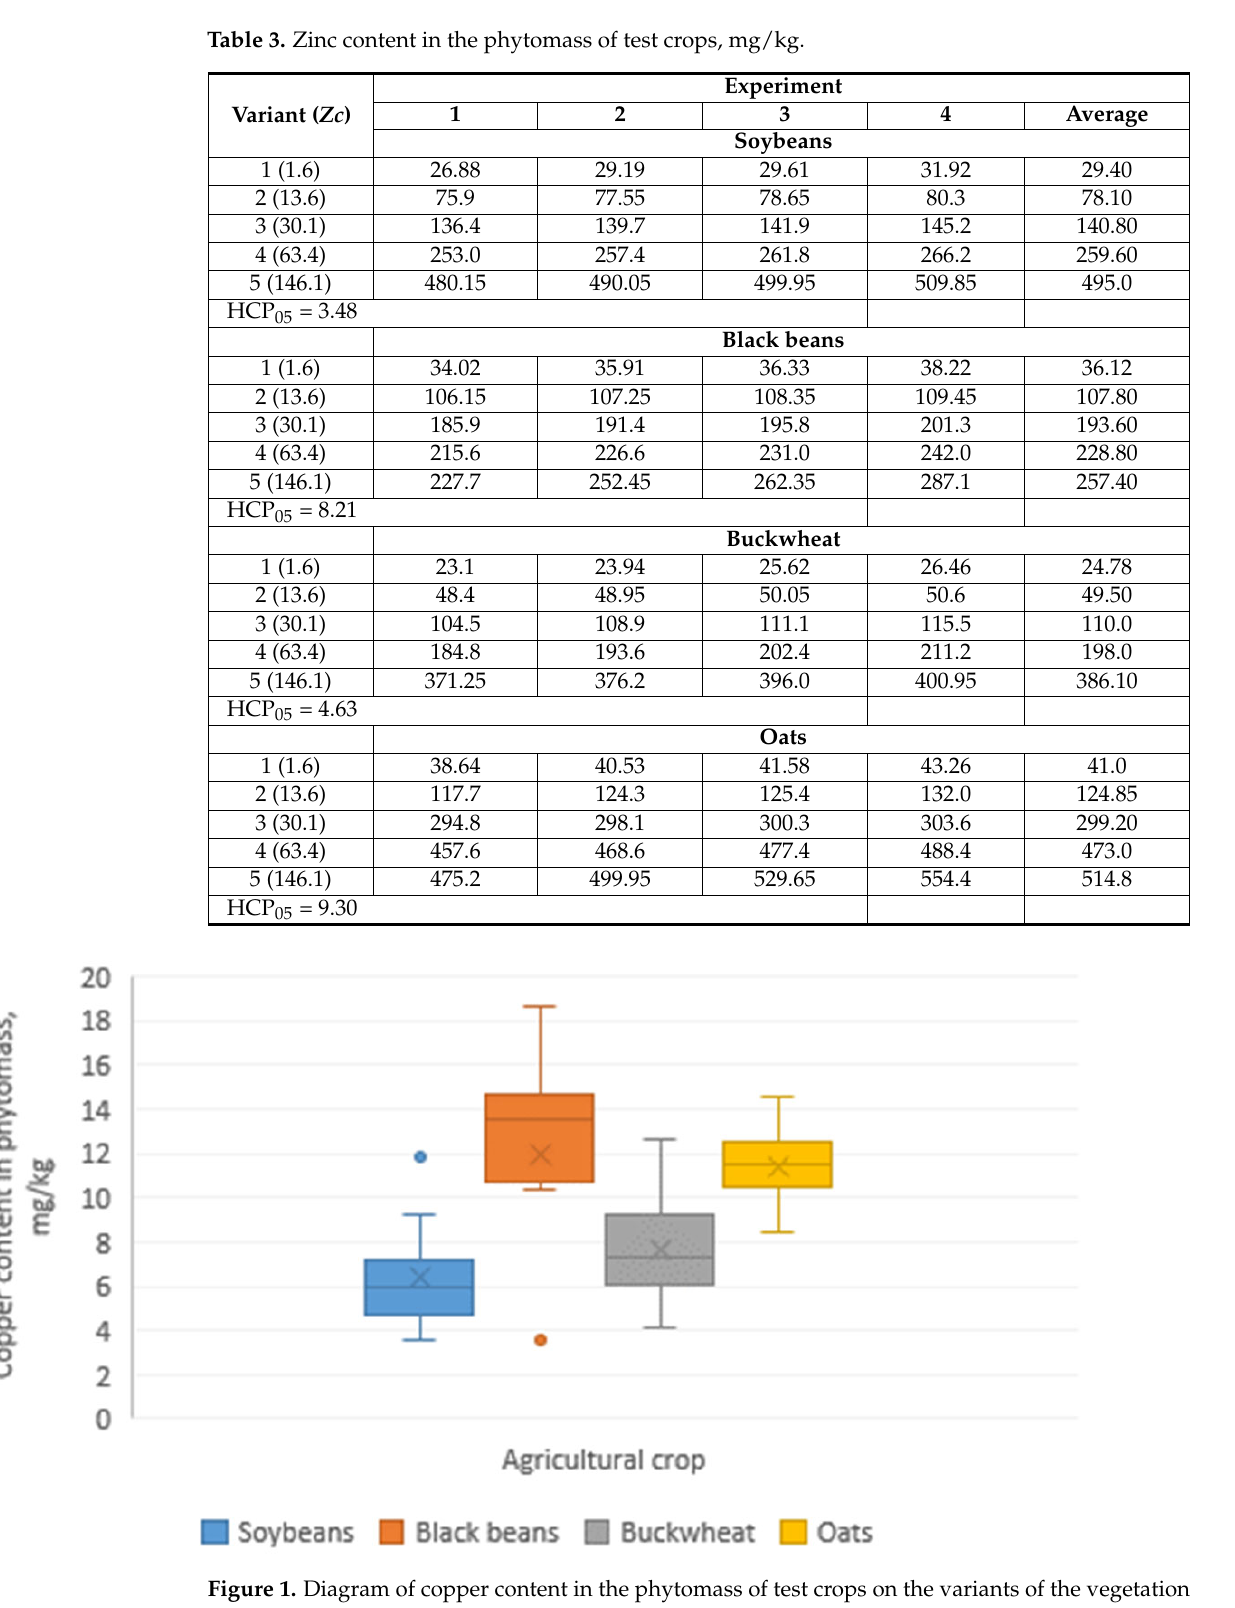
Figure 2. Diagram of zinc content in phytomass of test crops on the variants of the vegetation ex ‐ periment depending on the values of the total index of soil contamination.